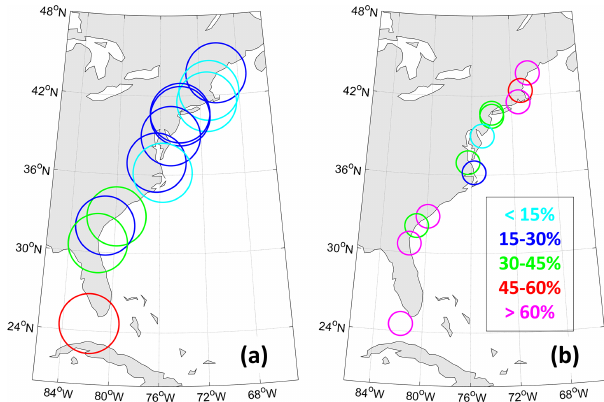
Figure 6. Percentage of TCs that produce surge exceeding the lo- cation’s 1-year return level and (a) are within 250km and (b) are within 100km and whose MSLP is less than or equal to the aver- age MSLP of all TCs within 100km. Size of circles indicates the search radius around each location. Color coding is based on the percentage value with < 15% (light blue), 15%–30% (dark blue), 30%–45% (green), 45%–60% (red), and > 60%